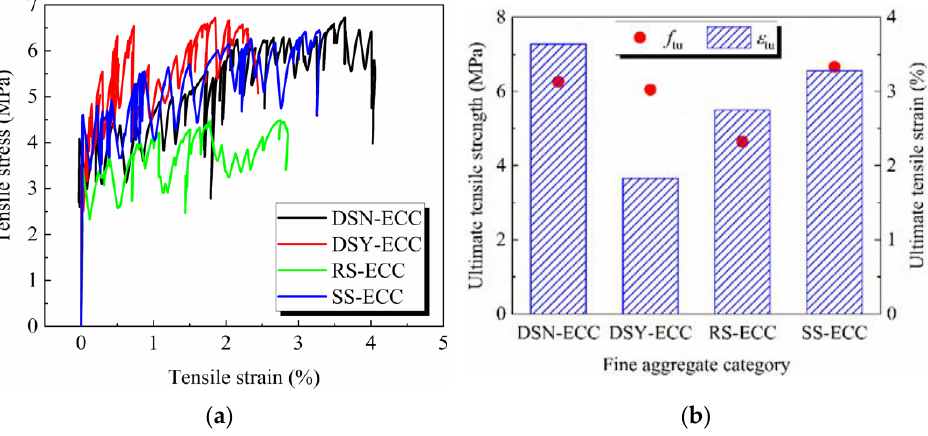
Figure 5. The fine aggregate category change group for ( a ) tensile stress–strain curves of ECC; ( b ) the relationship ultimate tensile strength and ultimate tensile strain of ECC. Table 4. Uniaxial tensile properties of ECC in different fine aggregates.